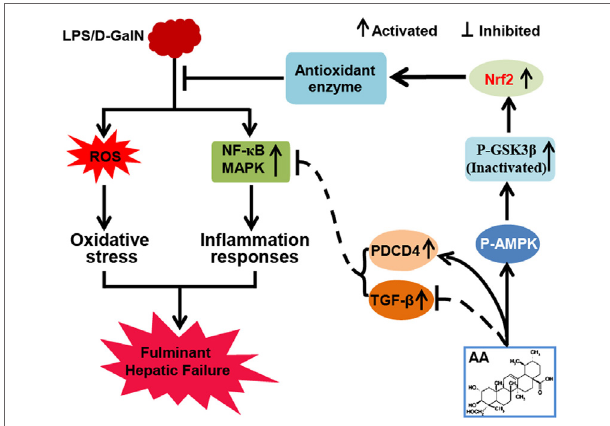
FigUre 7 | Asiatic acid (AA)-mediated Nrf2 signaling pathway protects lipopolysaccharide (LPS)/ d -galactosamine (GalN)-induced fulminant hepatic failure (FHF) via inhibition of oxidative stress and inflammatory responses. (AA) can induce AMP-activated protein kinase and GSK3 β activation, which contributes to upregulation of the Nrf2 signaling pathway and results in the expression of abundant antioxidant genes. Furthermore, AA not only reduces LPS/ d -GalN-induced reactive oxygen species overproduction but also inhibits NF- κ B and mitogen-activated protein kinase (MAPK) signaling pathway activation dependent upon induction of PDCD4 protein expression. These processes play significant roles in suppressing oxidative stress and inflammatory responses to alleviate